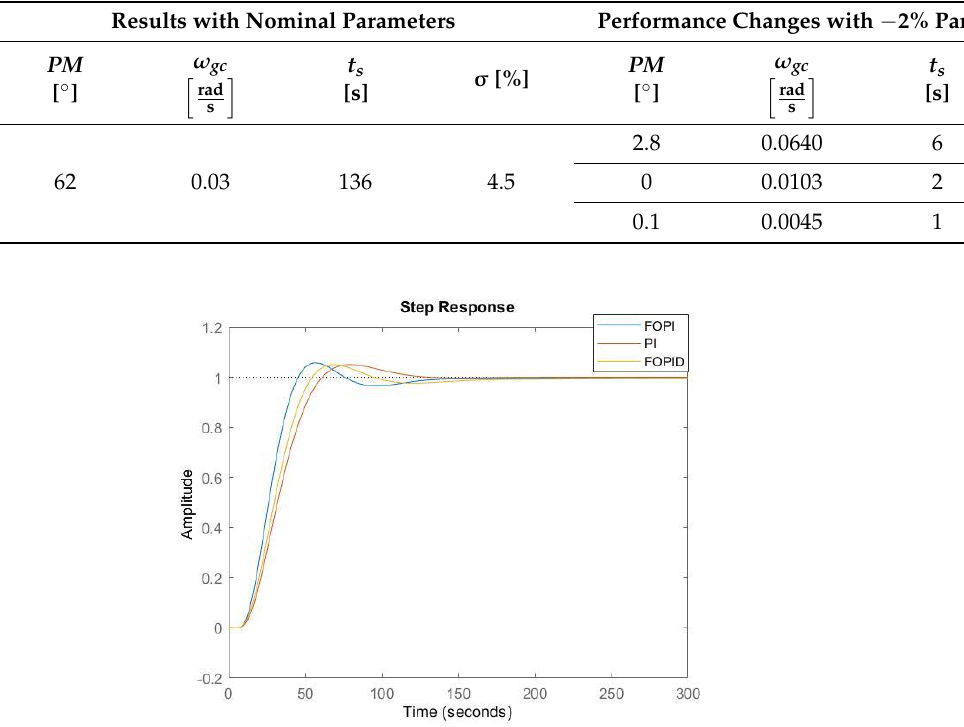
Figure 14. Step responses of the closed-loop system for the integer-order PI, FO-PI, and FO-PID controllers in the case of +2% process changes.